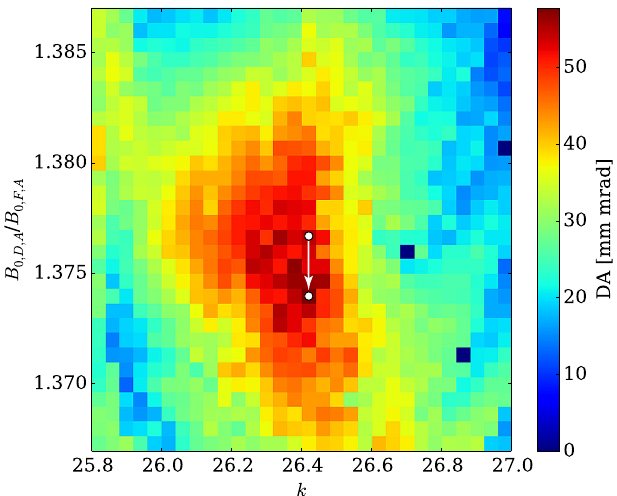
FIG. 14. The DA in the parameter space around the region found by the optimization procedure in P y Z goubi for the racetrack lattice. The original and optimized DA points are shown by white points and a white arrow indicating the direction of